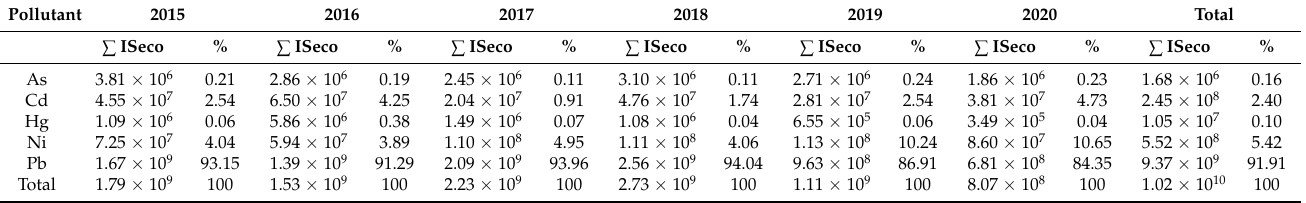
Table 7. Total impact scores obtained in the period 2015–2020 and the contribution of heavy